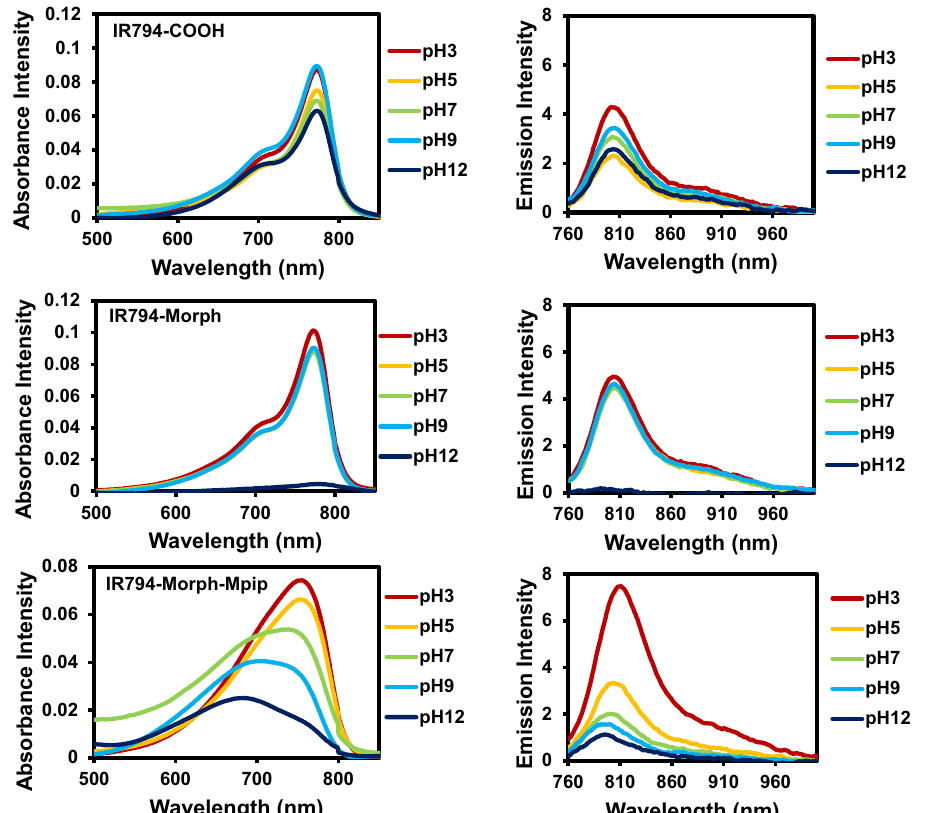
Figure 3. Vis–NIR absorption and fluorescent spectra of IR794 in different pH 3.0–12.0.